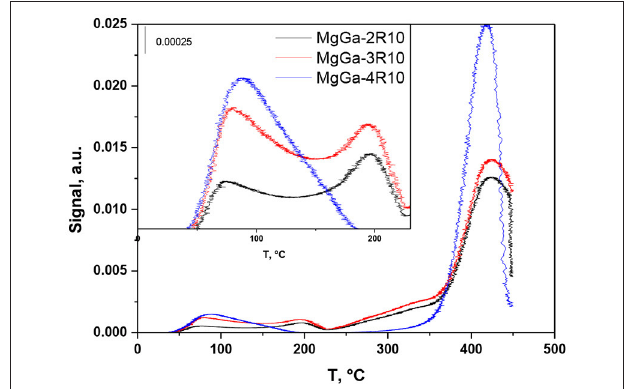
FIGURE 10 | CO 2 -TPD profiles for reconstructed MgGa